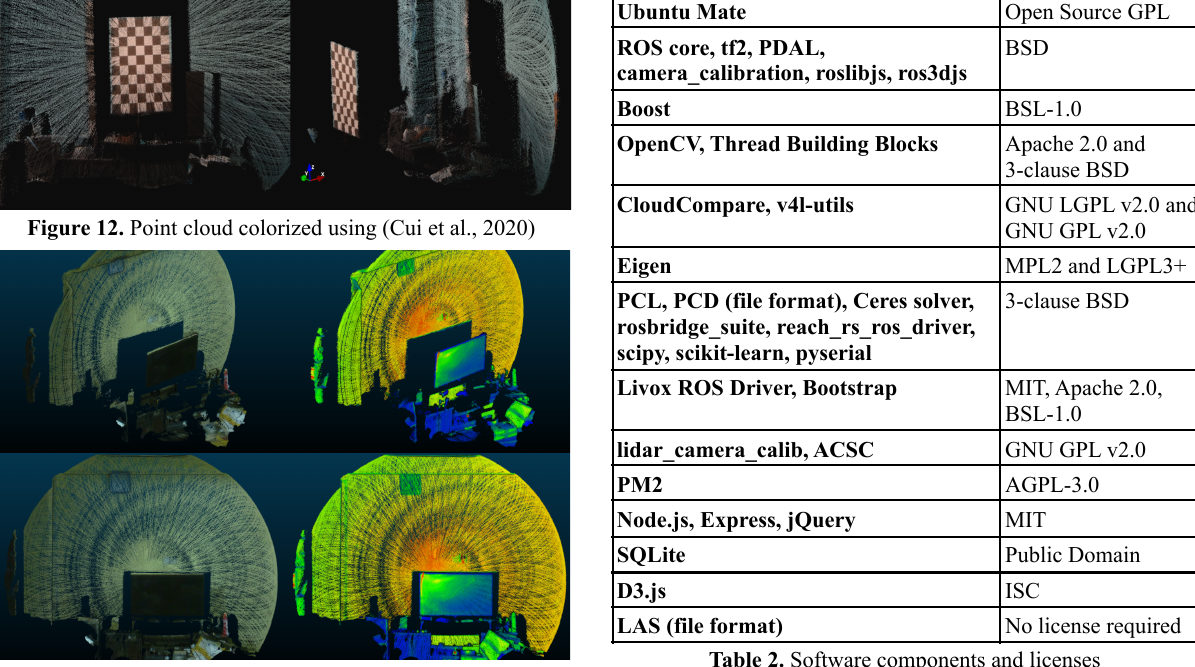
Figure 13. Point cloud colorized using (Yuan et al. 2021)